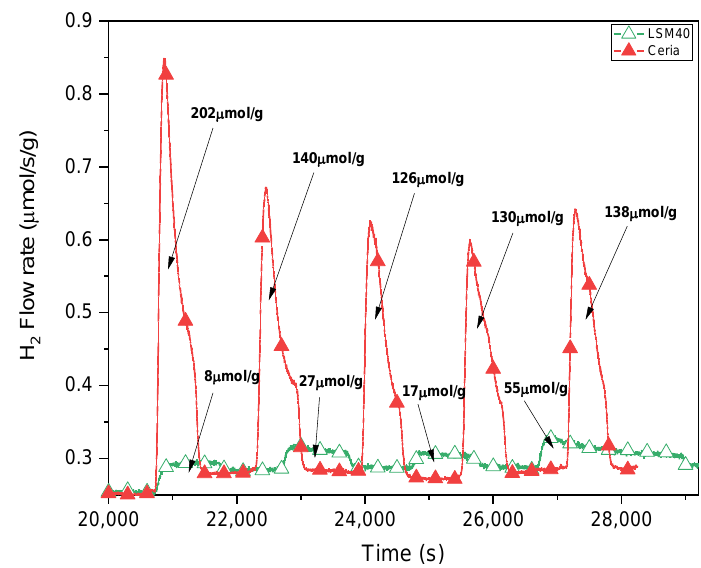
Figure 6. Comparison in H 2 production during 5 and 4 consecutive temperature-swing cycles with H 2 O splitting of porous ceria and LSM40 pellets, respectively. Numbers in μmol with arrows are the total H 2 production for each reaction. Symbols are for visual purposes